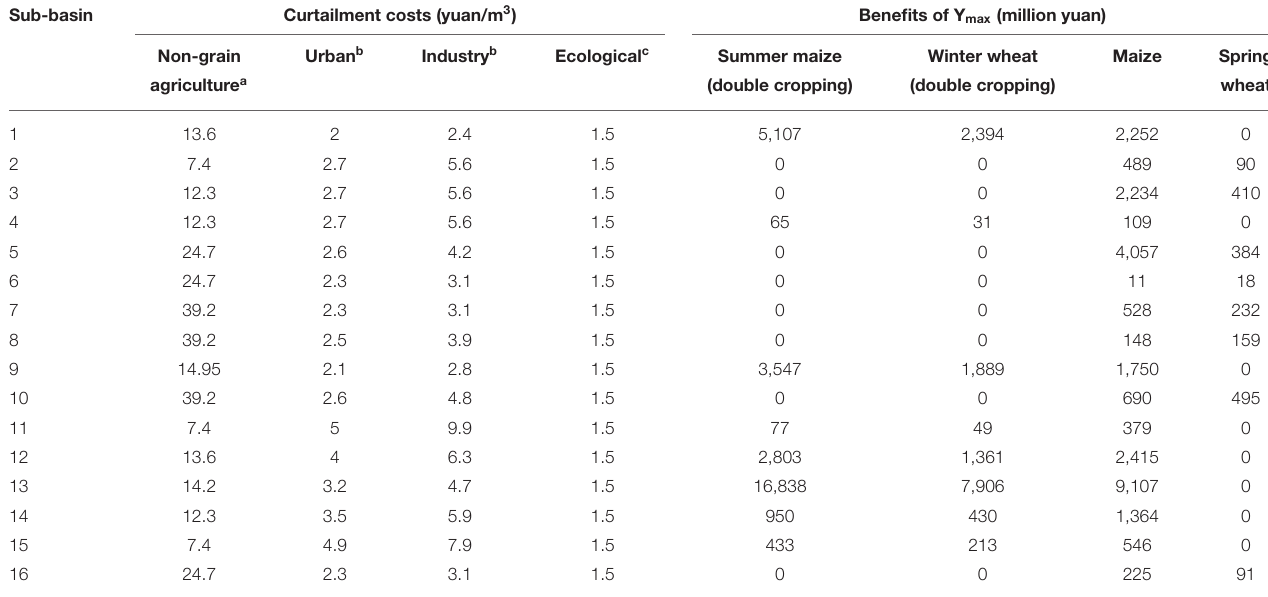
TABLE 2 | Economic input data of curtailment costs of monthly curtailments and yield benefits at the end of the growing season.